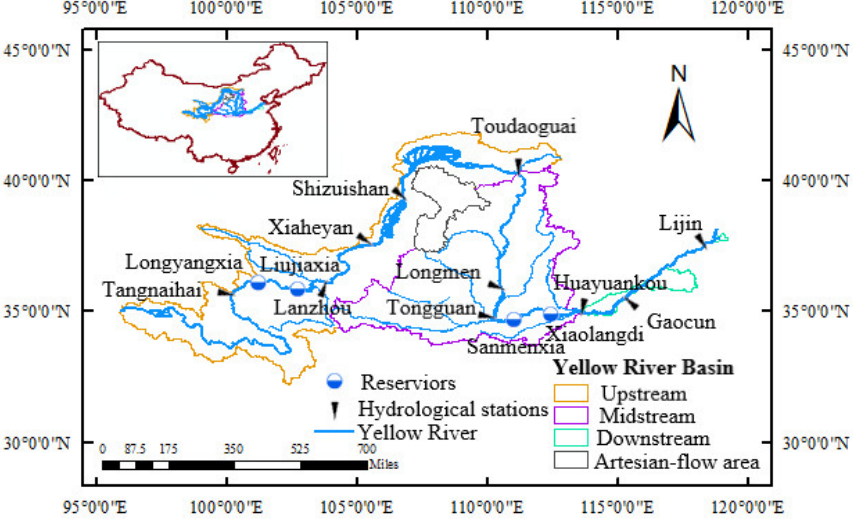
Figure 1. Location of the Yellow River basin, 10 hydrological stations and large reservoirs.